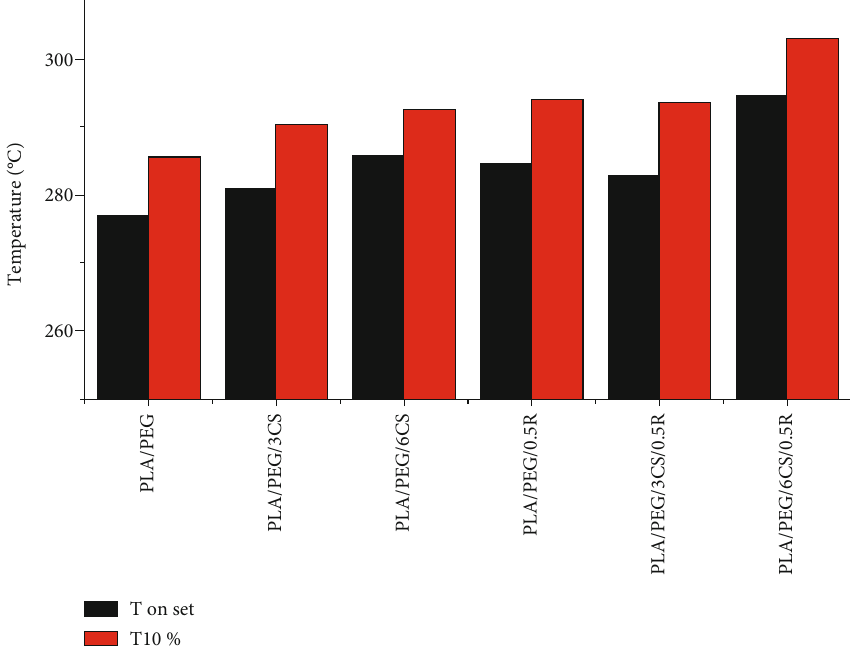
Figure 6: The variation of the T